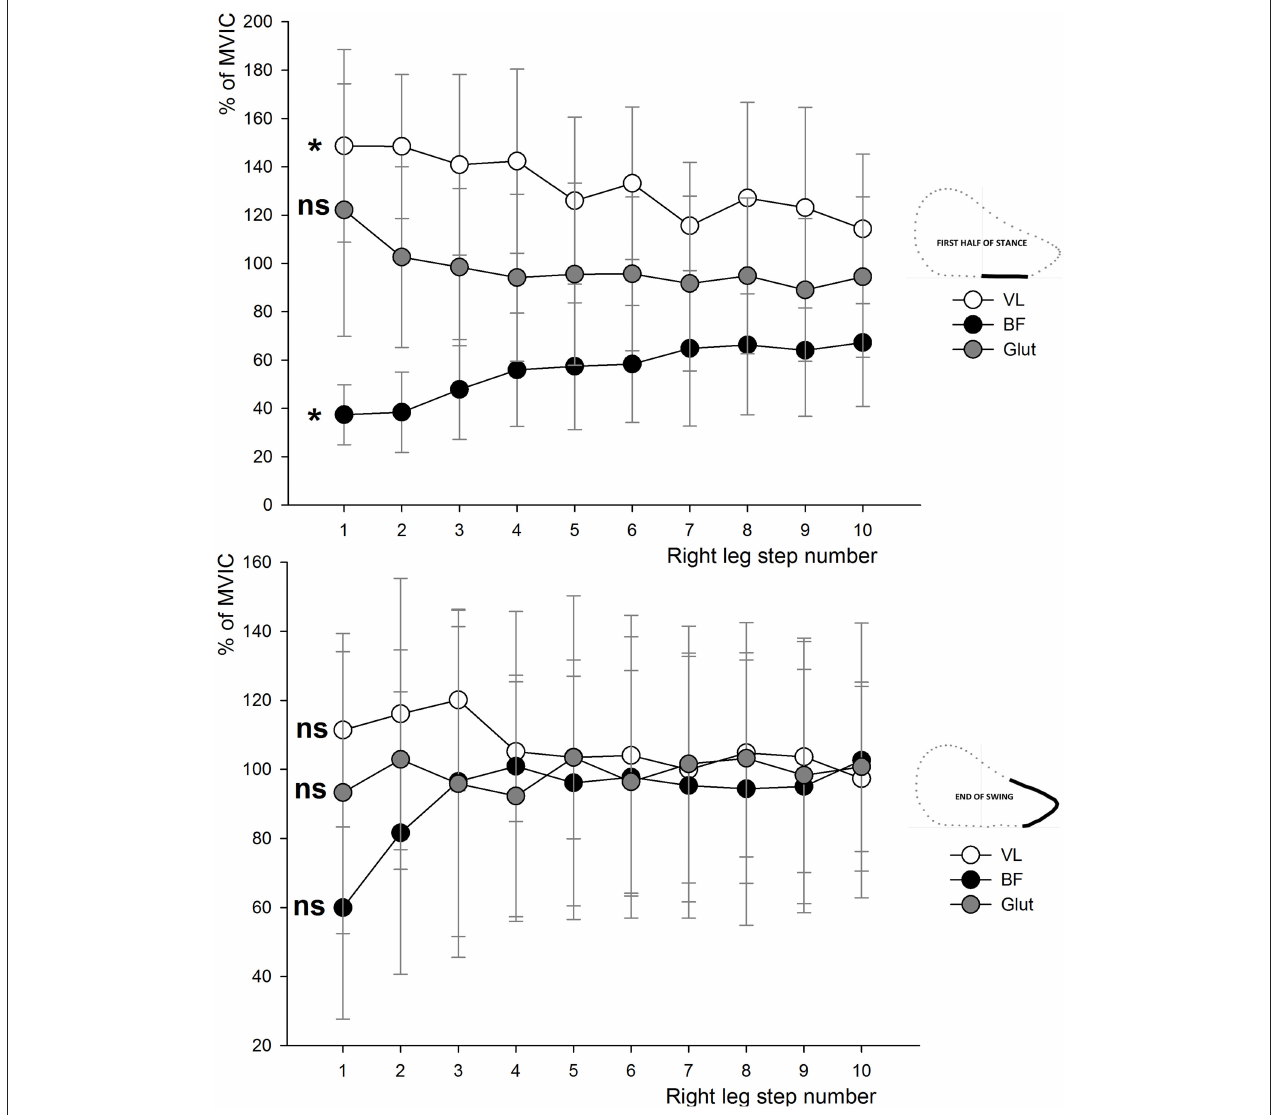
FIGURE 4 | Average EMG activity ( ± SD) of the VL, BF, and Glut muscles during the first half of the stance and the end-of-swing phase for all the right leg steps of the sprint acceleration. VL, vastus lateralis ; RF, rectus femoris ; BF, biceps femoris ; Glut, gluteus maximus ; MVIC, maximal voluntary isometric contraction. The effect of “step number” over the entire acceleration were tested by One-way analyses of variance: * , ANOVA significant main effect ( P < 0.05 ); ns, not